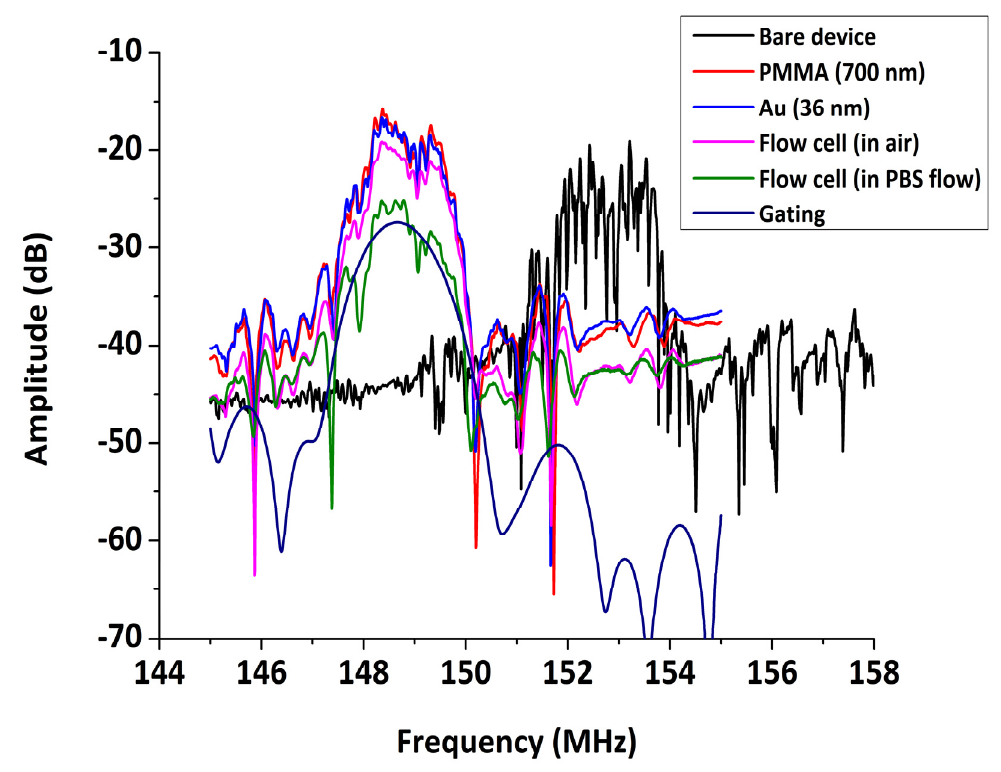
ff erent stages prior to